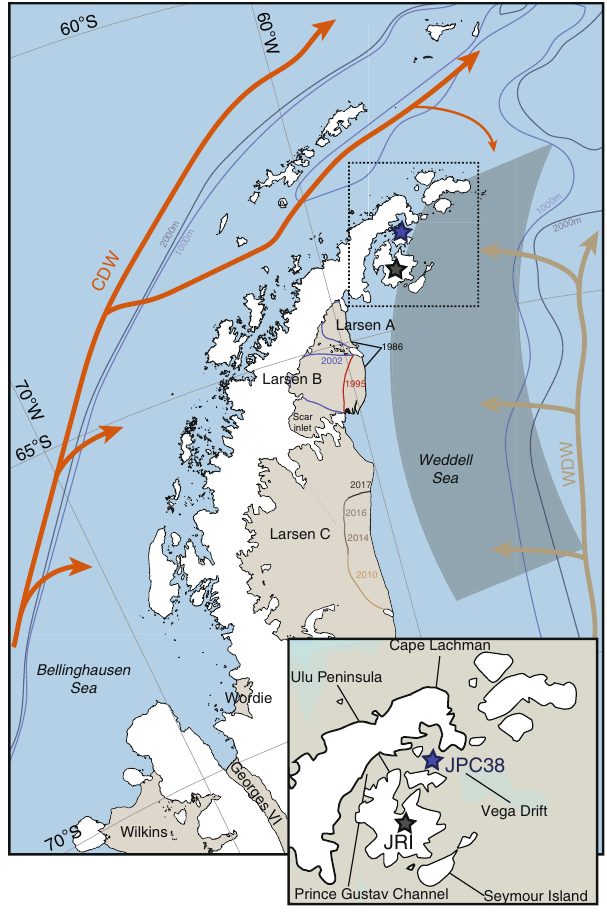
Fig. 1 The Antarctic Peninsula and the recent shifts of the ice shelf boundary. Shown is the drastic retreat of ice shelves (Larsen A and B) along the EAP margin since 1986, the recent crack of the Larsen C since 2010, the study site (JPC-38) (63.717°S, 57.411°W, 760 m water depth) (blue star) and the JRI ice core (black star) 27 . The arrows show the circulation of the CDW (orange) and WDW (light brown) around the Peninsula. Reanalyzed data and model simulations have been computed along the EAP margin (i.e., in the gray area). Dark and light blue lines correspond to the bathymetry at 2000 and 1000 m depth and delineate the continental